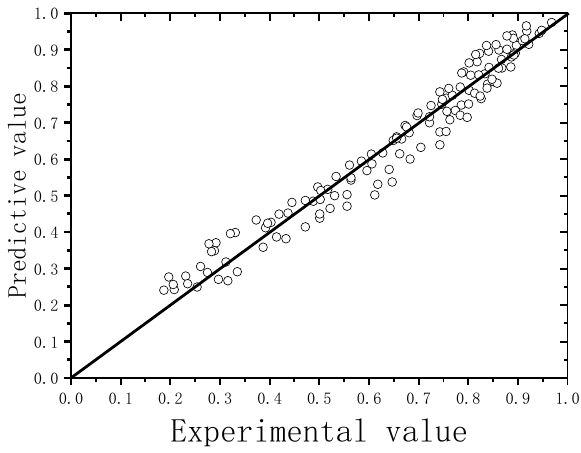
Figure 5. Verification of the kinetic model.